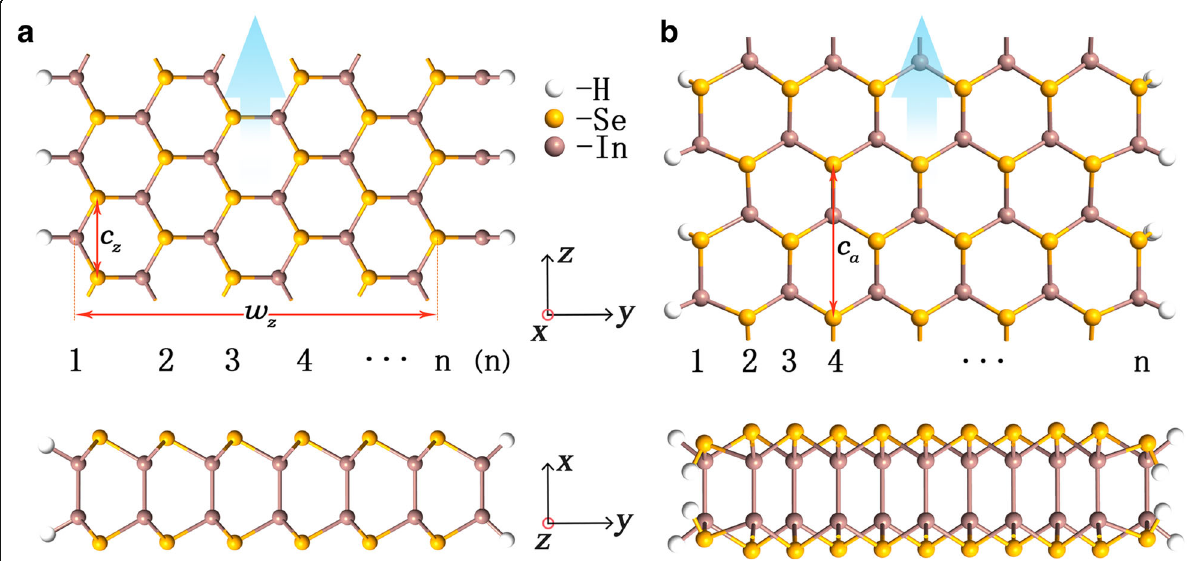
Fig. 1 Top and side views of 6-HZKH ( a ) and 11-HAAH ( b ) InSe nanoribbons. Nanoribbon width number n , width w z , and lattice constants c z or